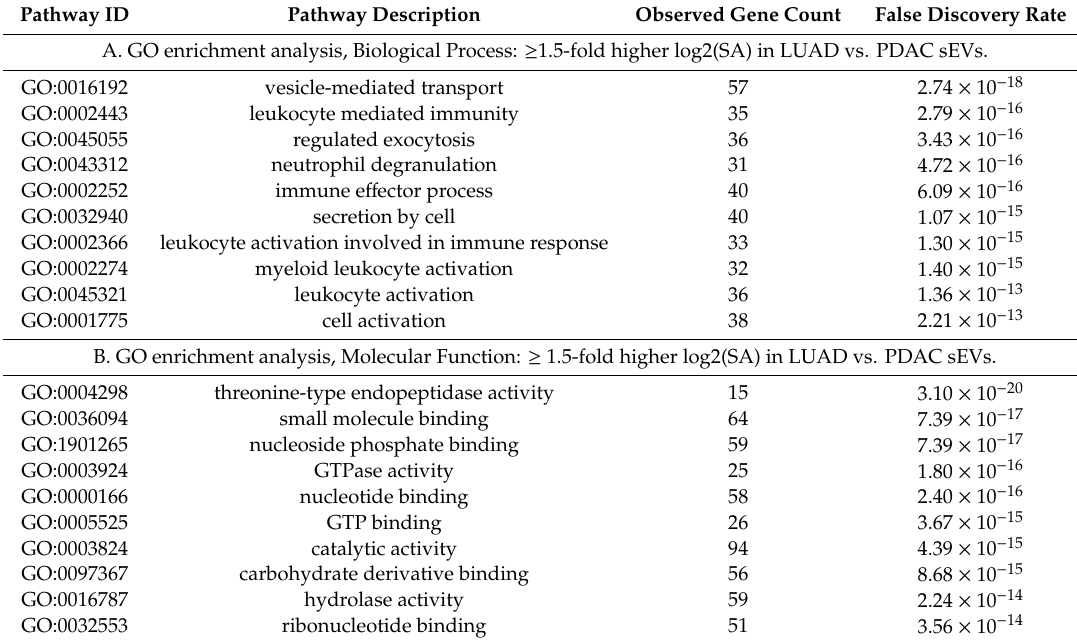
Table A3. GO enrichment analysis of 174 sEV protein features identified with ≥ 1.5-fold higher log2(SA) in LUAD vs PDAC panel cell line sEVs. Top ten statistically enriched GO